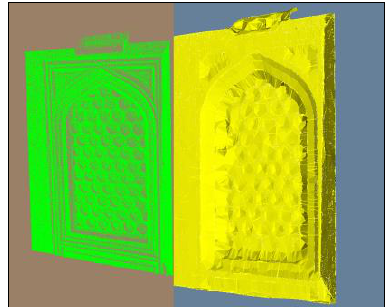
Figure 6. Detailed point cloud view of a window and its generated simplified triangulated surface as a intermediate.